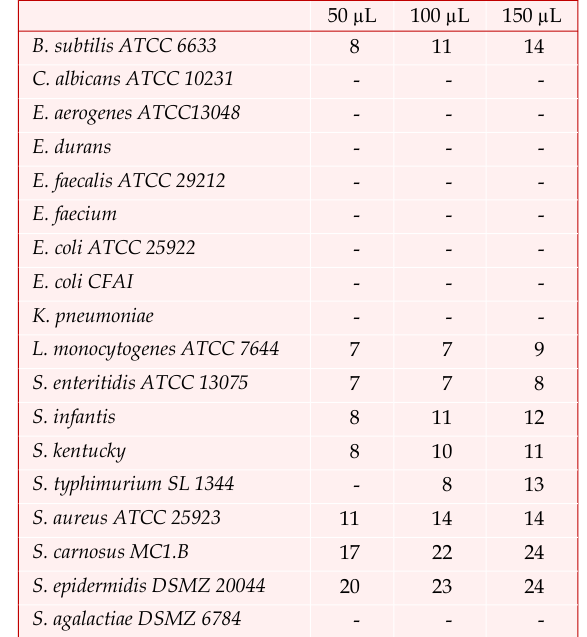
Disk diffusion test results (Inhibition zones in